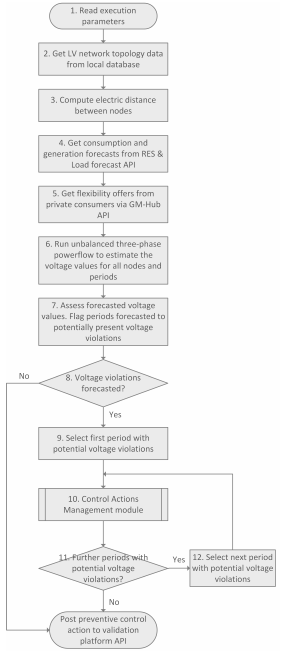
Figure 4. Preventive control module flowchart.